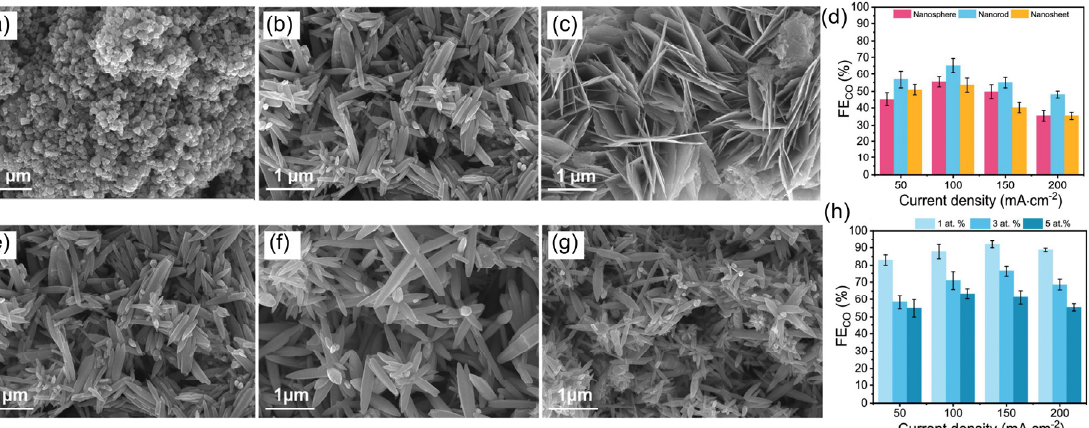
Figure 10. ( a ) FE-SEM of nanosphere ZnO, ( b ) FE-SEM of nanorod ZnO, ( c ) FE-SEM of nanosheet ZnO electrocatalysts before CO 2 RR, respectively. ( d ) FEs (%) of CO at different current densities on ZnO electrocatalysts with different morphologies. ( e ) 1 atom%, ( f ) 3 atom%, and ( g ) 5 atom% of Ag doping and ( h ) FEs (%) of CO at different current densities on ZnO electrocatalysts with different Ag doping [158]. Reproduced with permission from Ref. [158]. Copyright © 2023, American Chemical Society.